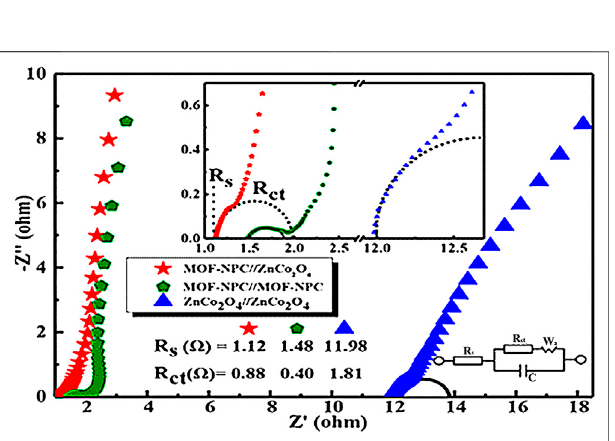
FIGURE 9 | Nyquist plots of three SCs fabricated based on TMOs and NPC derived from MOFs (the upper inset is the plots in the high-frequency regionandtheloweroneistheequivalent circuit)(Heet al.,2020).Copyright